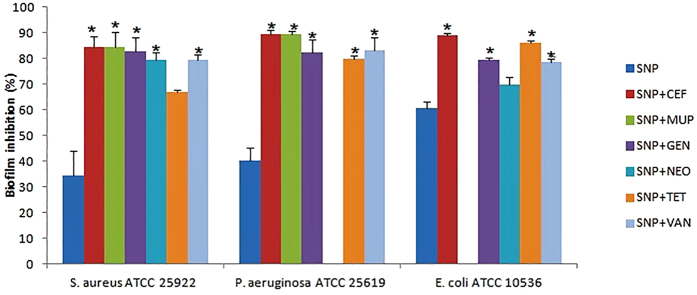
The inhibitory effect of SNP and combination with antibiotics on the biofilm formation.Values are expressed as means (n = 3), and error bars represent standard deviations. Asterisks (*) indicate a statistical significant difference (P < 0.05) between the SNP alone and the combinations.